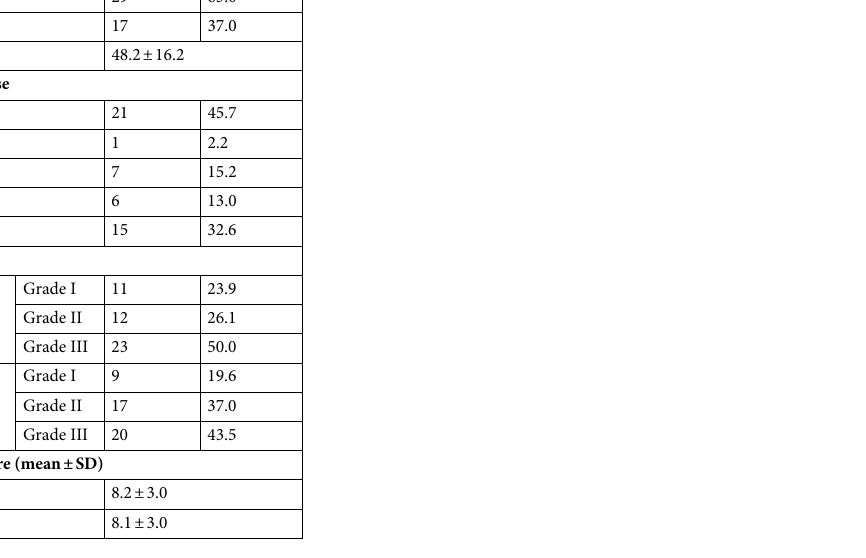
Table 1. Demographic